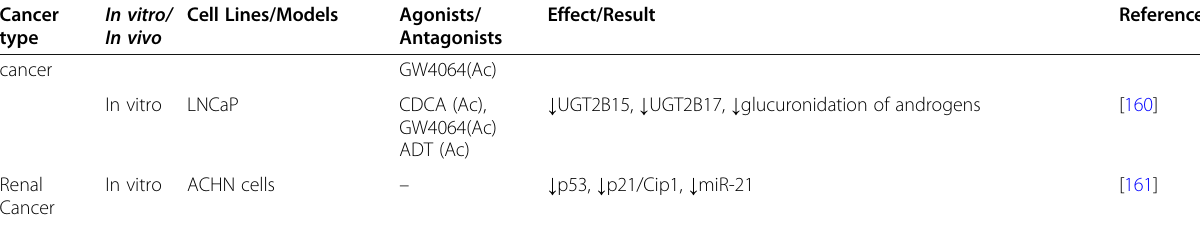
Table 1 Mechanistic role of FXR in various cancers in the presence of its agonists/antagonists (Continued) Cancer